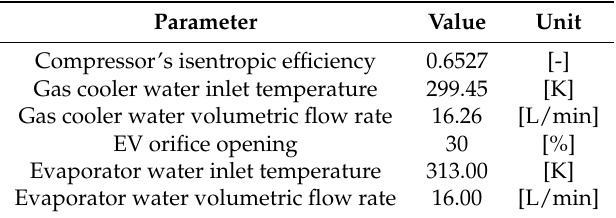
Table 2. System input parameters (30% EV orifice opening).